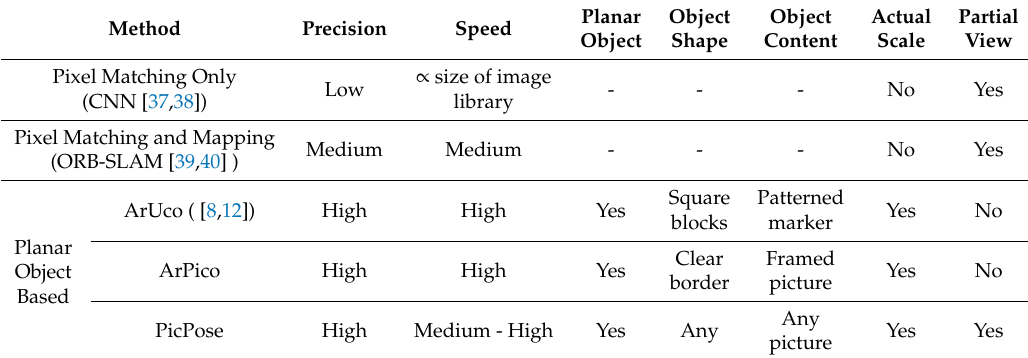
Table 1. Comparison of Visual-Based Localization (VBL)